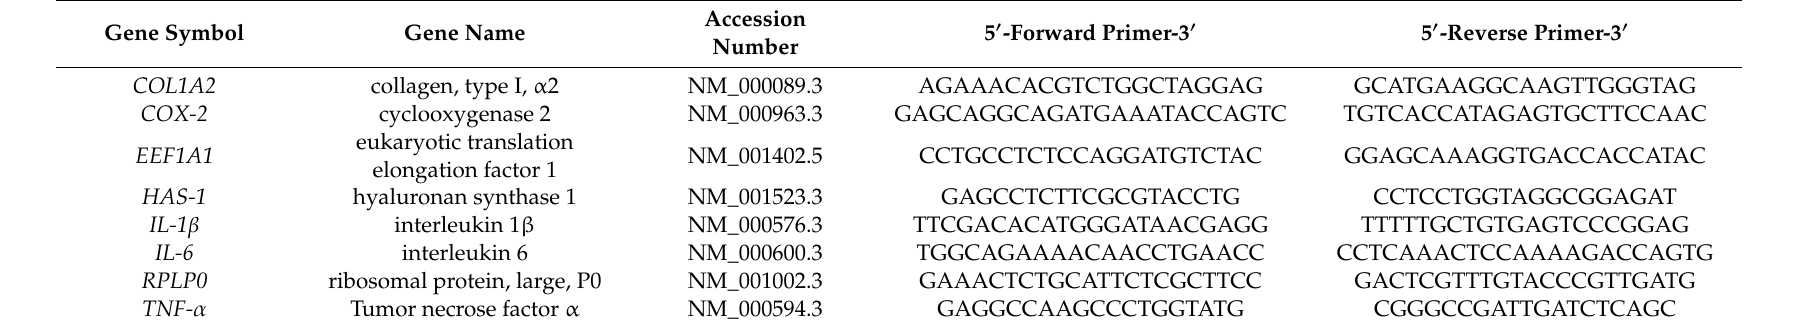
Table 1. Reference genes ( EEF1A1 , RPLP0 ) and targets used for RT-qPCR in human synovial